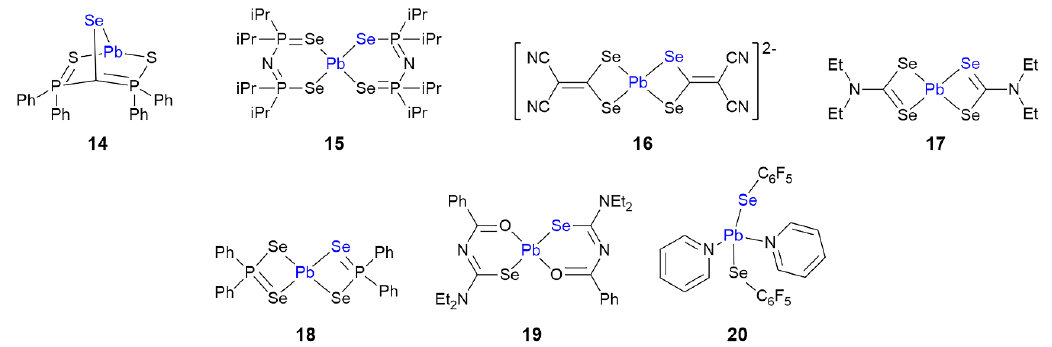
Figure 4. Chemical diagrams for lead compounds 14 – 20 .